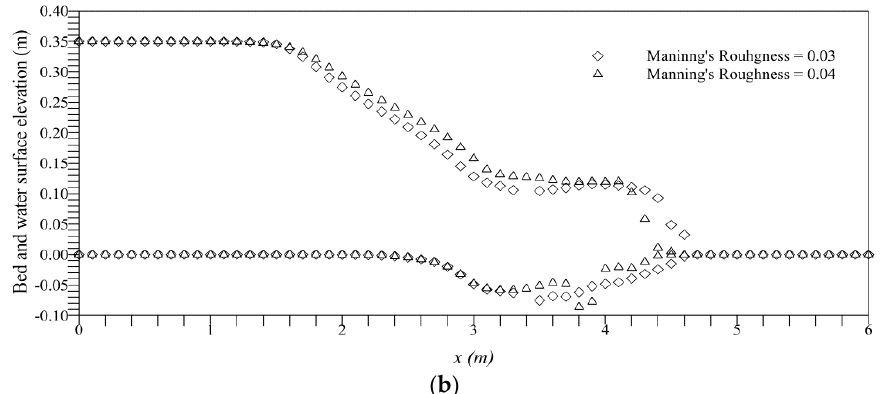
Figure 11. Sensitivity analysis for Configuration 1 to the model parameters at t = 0.75 s: ( a ) porosity p; and ( b ) Manning’s n.